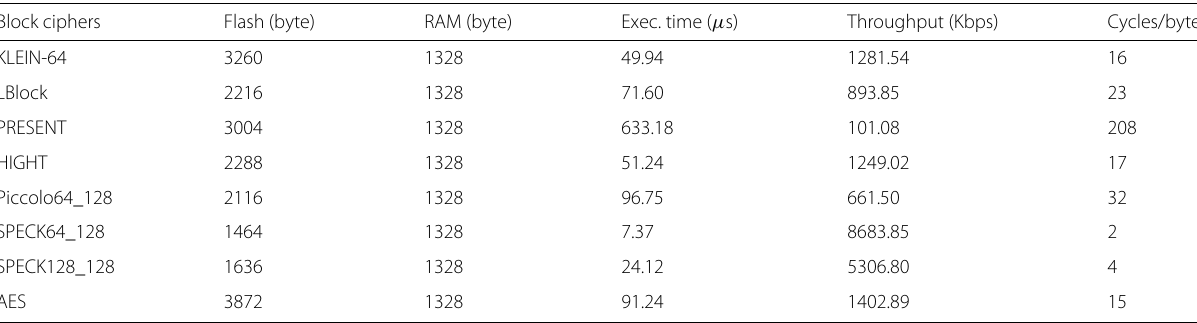
Table 7 Performance of mode -O3